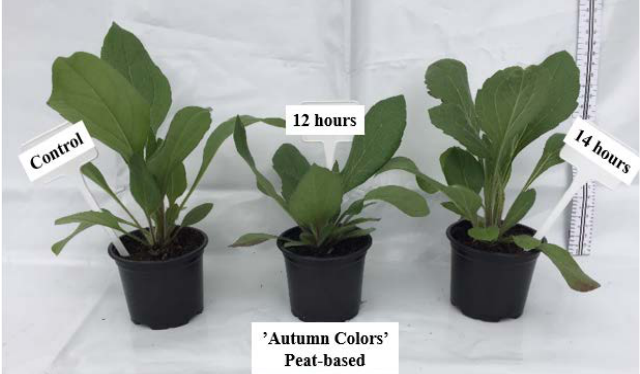
Figure 9. 11 weeks-old Rudbeckia hirta ‘Autumn Colors‘ plantlets depending on photoperiodic lighting treatments in peat-based media (University of Debrecen, Biological Research and Plant Experiment Greenhouse - Biodrome, Debrecen, Hungary, 2021).